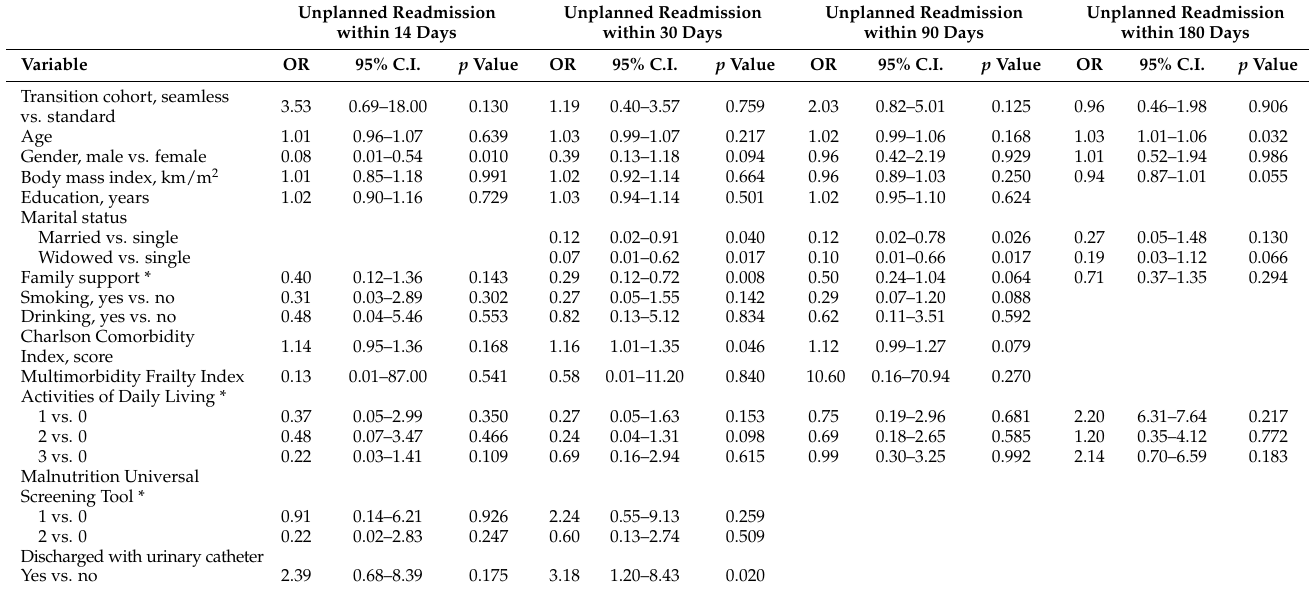
Table 2. Multivariate analysis of medical resource utilization and mortality in the two cohorts after adjustment for patient study